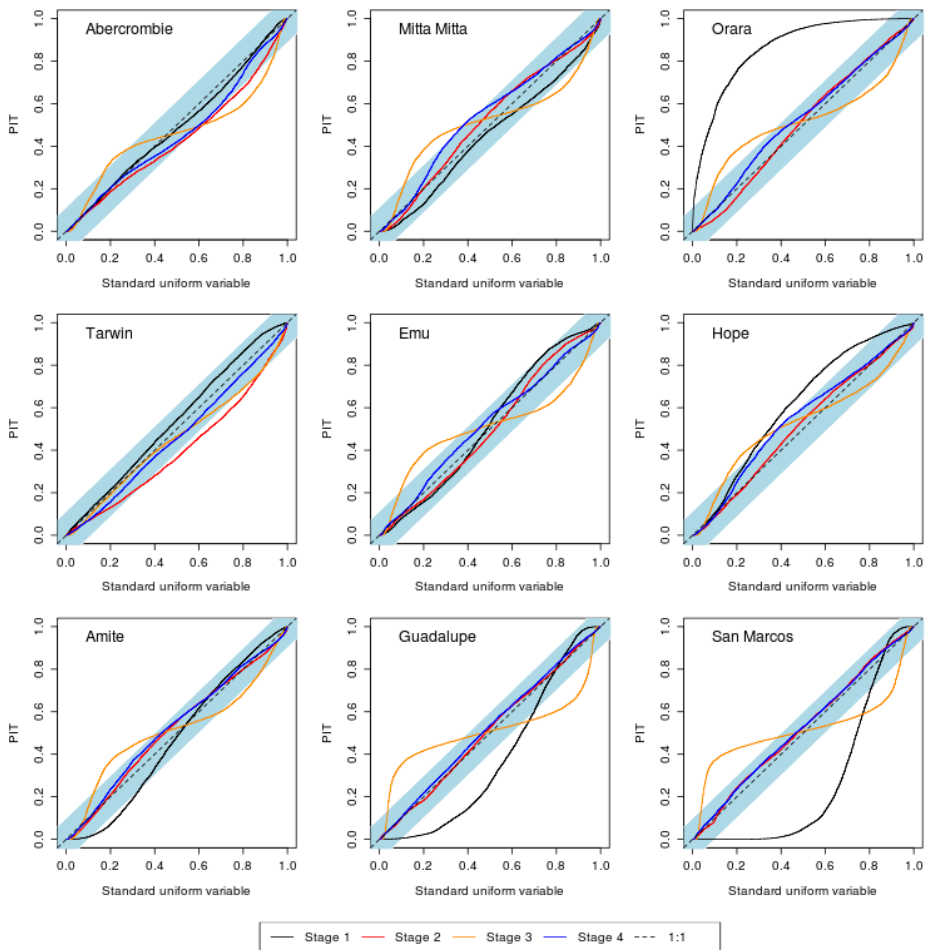
Figure 9. Same as Fig. 4 but the hydrological model is calibrated by the least-squares